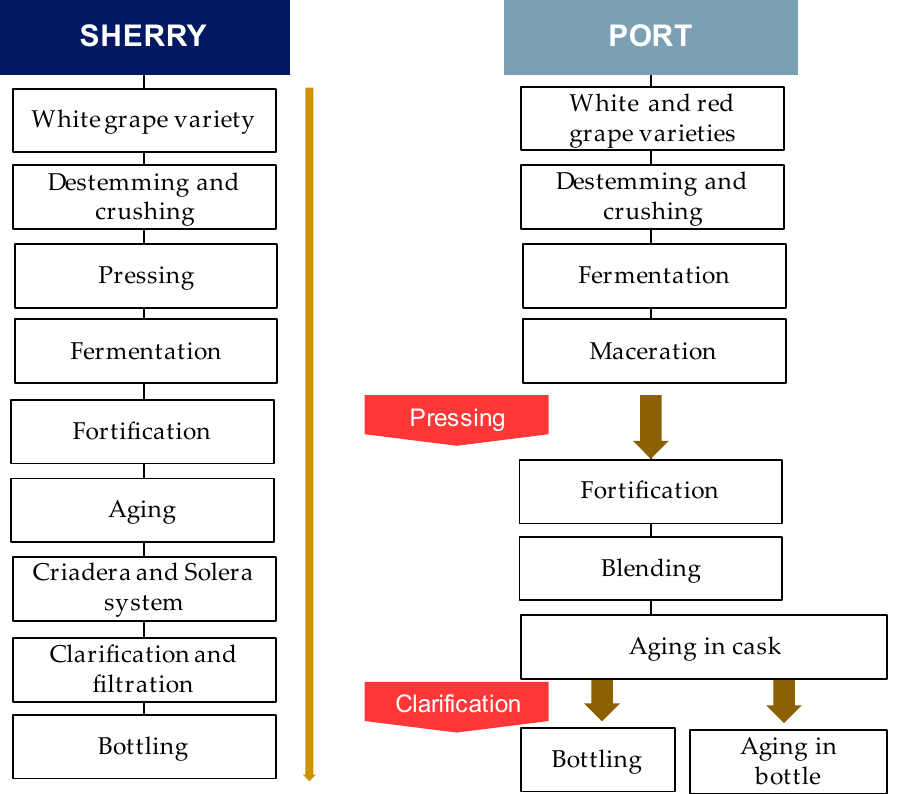
Figure 2. Sherry and Port’s winemaking processes.